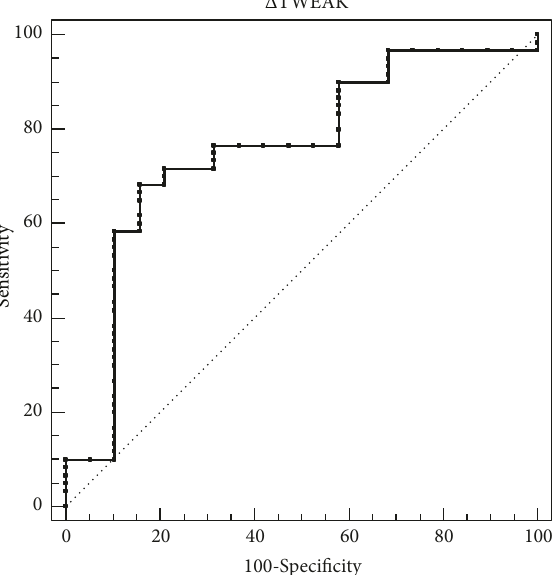
Figure 2: ROC curves of Δ TWEAK concentrations for 28-day mortality. Δ TWEAK concentrations refer to dynamic changes of TWEAK concentrations between 1st day and 3rd day of admission to